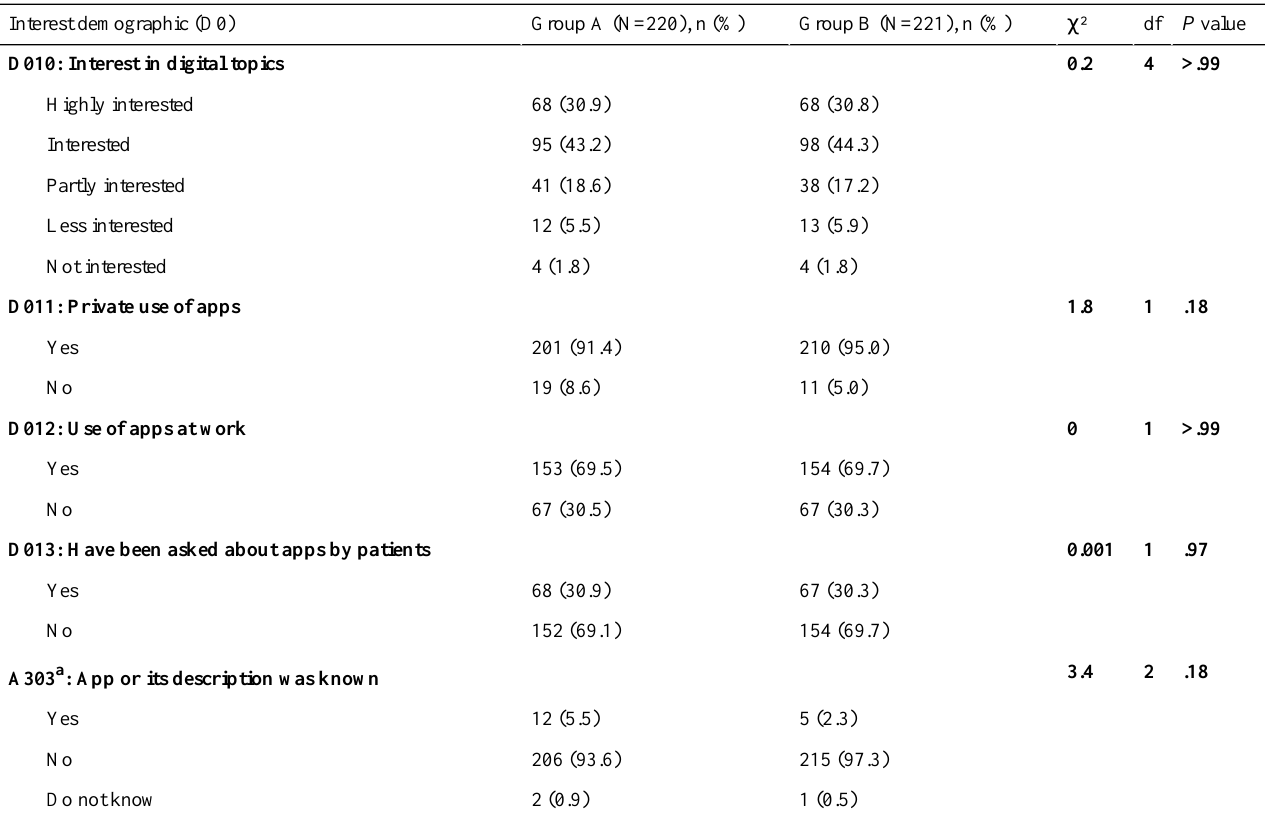
Table 7. Interest in digital topics and app usage patterns, stratified by randomly assigned groups A and